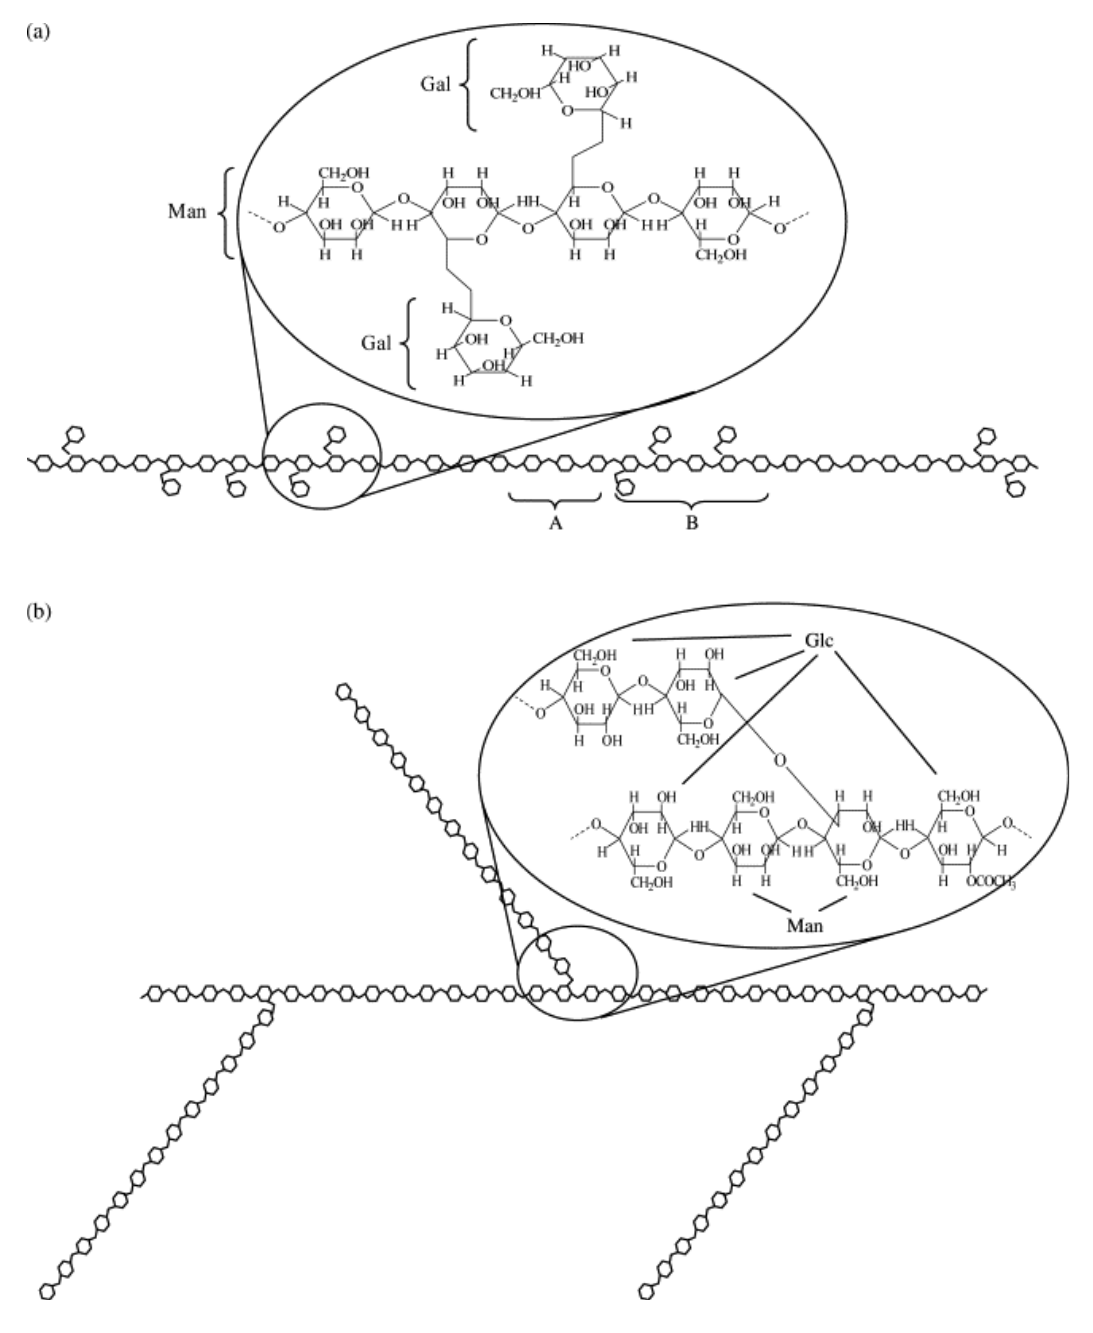
Figure 2. General structure of galactomannan ( a ) and glucomannan ( b ) (adapted from Vieira and Gil